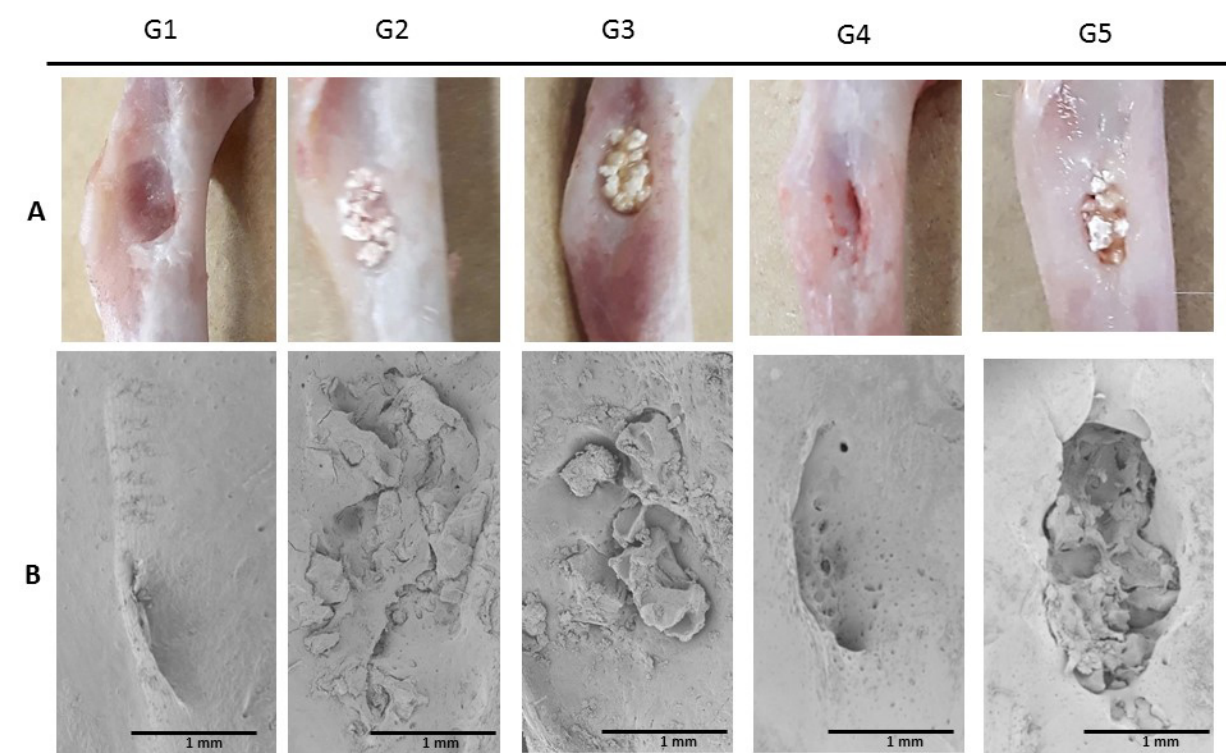
Figure 8. Representative images of the region of interest: (A) macroscopic and (B) by scanning electron microscopy view, 30 days after surgical procedure.